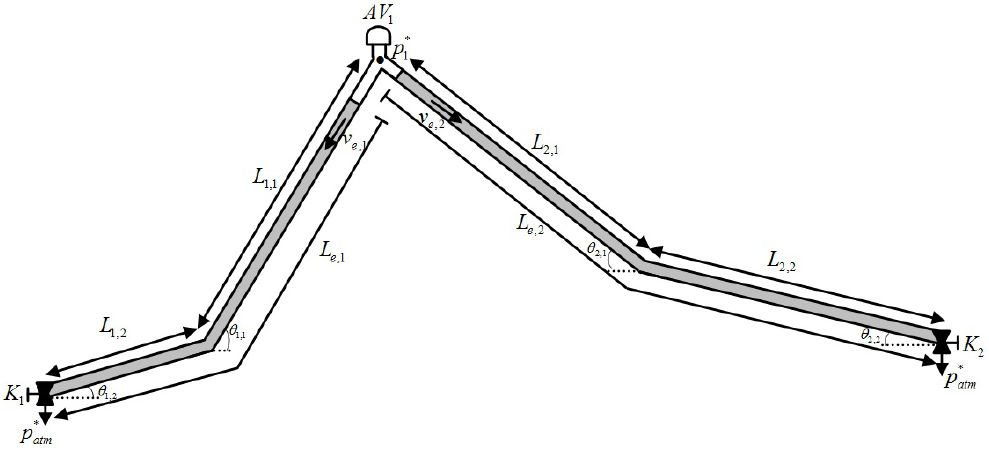
Figure 3. Two emptying columns in a